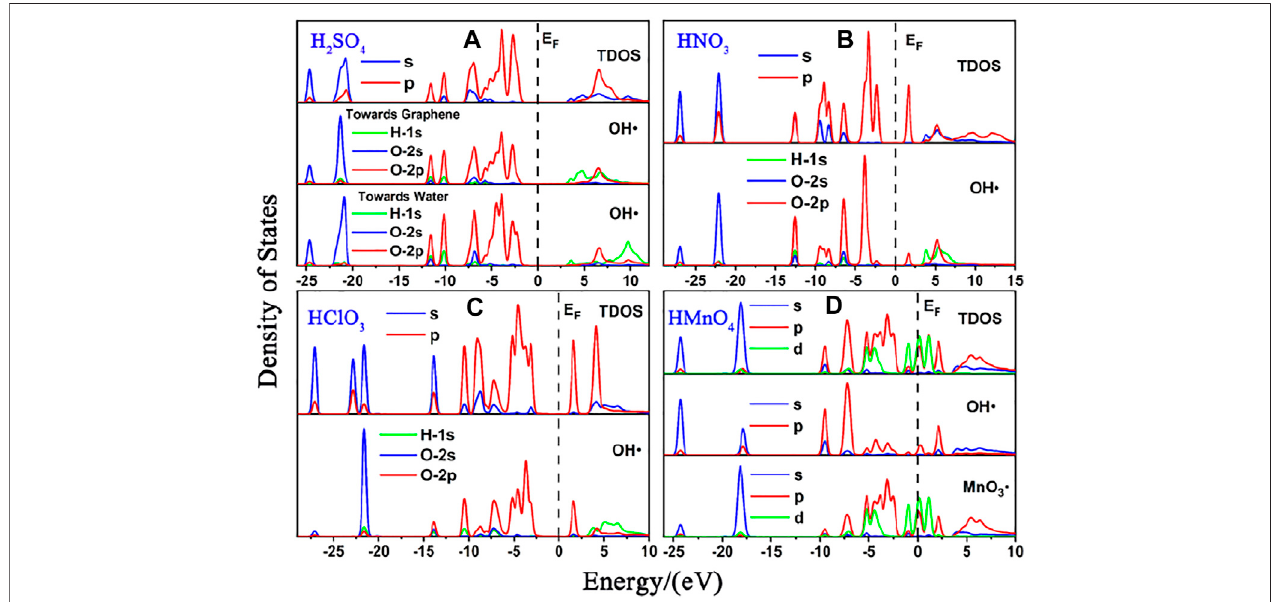
FIGURE4| DOSofsingle-componentacidmolecules reacting withthenon-defectivegraphene inaqueous condition. (A) , (B) , (C) ,and (D) aretheDOSofH 2 SO 4 , HNO 3 ,HClO 3 andHMnO 4 ,respectively.Ineachdiagram,thetoprepresentstheTDOS,andthebottomrepresentstheLDOSofOH (cid:129) of MnO 3 at the bottom of (D) .